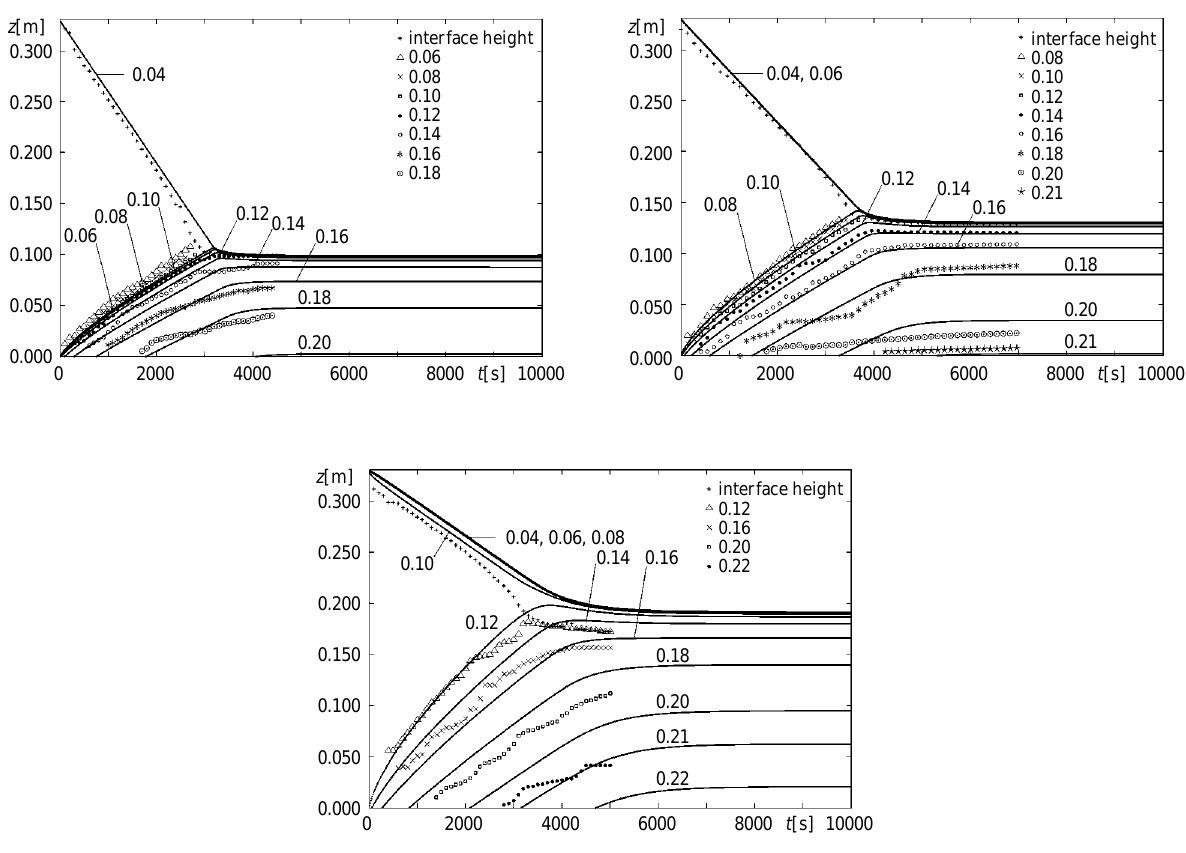
Simulation of batch sedimentation of a talc suspension in a column, after Bürger and Karlsen (2001): settling plots for three different initial concentrations (0.052, top left, 0.072, top right, and 0.112, bottom). The symbols denote the measured iso-concentration